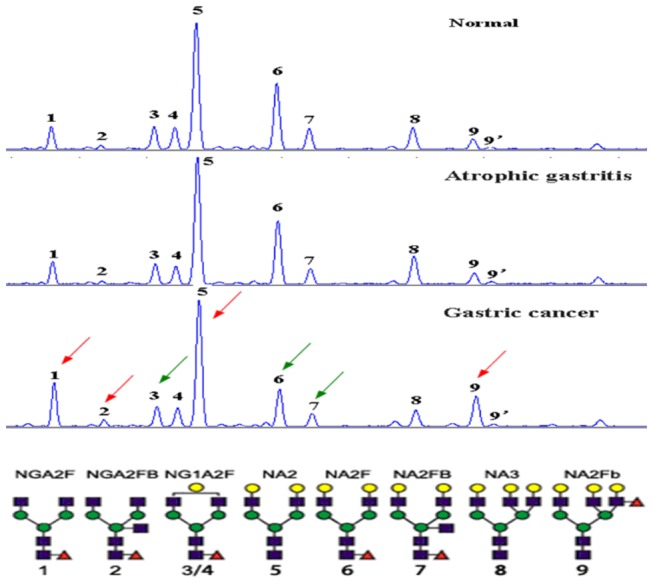
A typical desialylated N-glycan profile of serum protein.At least 9 peaks can be identified. Peaks 1, 2, 5 and 9 increased (red arrows), and peaks 3, 6 and 7 decreased (green arrows) in gastric carcinoma compared with normal controls. The structures of the N-glycan peaks are shown below the chart. The open circles indicate b-linked galactose; the triangles, a/b-1,3/6-linked fucose; and the solid circles, a/b-linked mannose.